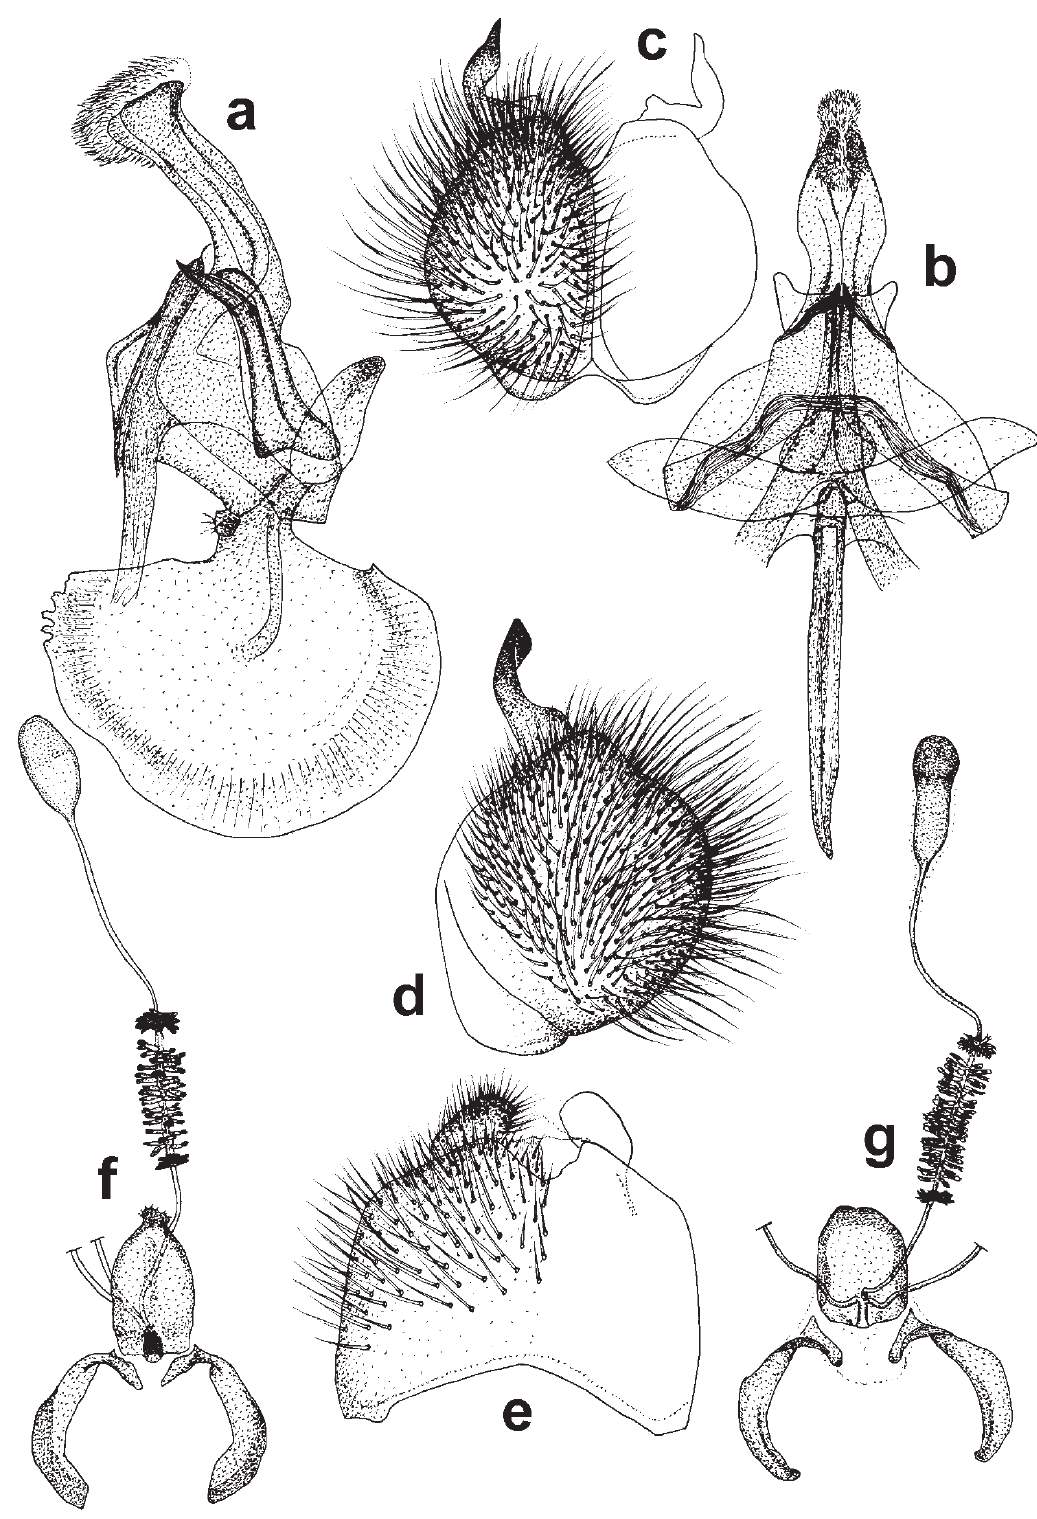
Fig. 65. Parusia loewi (Becker, 1906) gen. et sp. nov. a . Epiphallic complex ventral. b . Epiphallic complex lateral. c . Gonocoxite ventral. d . Gonocoxite lateral. e . Epandrium dorsal. f . Female genitalia ventral (Marbella). g . Female genitalia ventral